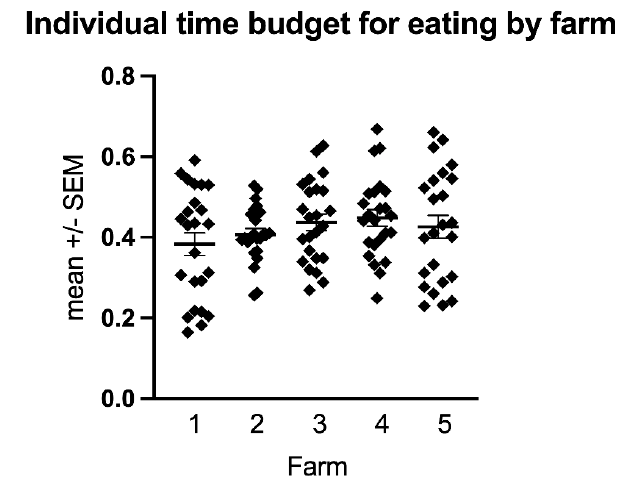
Figure 7. The scatter plot shows the individual mean time budget for eating for all horses included in this study divided by farm. For each farm, the mean ± SEM is indicated. The time budget for eating is similar for most horses except for a few outliers, which might be an indication for potential health or welfare issues. Supplementary Materials: The following are available online at www.mdpi.com/xxx/s1. Table S1: Details of the different farms’ housing and turn-out characteristics. Table S2: List of all horses in- cluded in this study, detailing their age, sex, breed and time budgets by tracking period (round) and whether they were stabled on edible bedding and received additional food. Table S3: The time budg- ets (mean ± s.d.) are detailed by farm, tracking period (round) and time of the day. Table S4: The CVg (=intra-individual variability; for horse: intraindividual, for farm/turn-out condition/time of day: within the same farm/turn-out condition/time) and Cvi (=inter-individual variability; for horse: between horses, for farm/turn-out condition/time of day: between farms/turn-out conditions/times) are detailed for the time budgets and activity counts by horse, farm, turn-out condition and time of day.